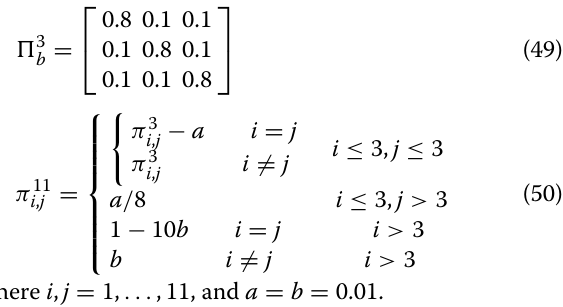
where measurement noise v k is the zero-mean Gaussian distribution with the unknown covariance matrix (cid:2) k . The initial degree of freedom and symmetric positive definite matrix are κ 0 , i = 5 ( i = 1, 2 ) , (cid:5) 0 = diag { 20, 20 } . The turn rates ω i , ω j belong to the following set (cid:9) (cid:8) ω ω ∈ − 6.67 × 10 − 4 , 0, 6.67 × 10 − 4 ∈ M b i i ω ∈ π × 10 − 3 × ( ± 4.2, ± 5.6, ± 8.3, ± 16.7 ) ω ∈ M c j j The transition probability matrix (TPM) of the IMM11 ) (cid:14) 11 = (π 11 11 × 11 is extended from the TPM of the basic i , j = (π 3 ) models set. The TPM (cid:14) 3 3 × 3 is shown as i , j b